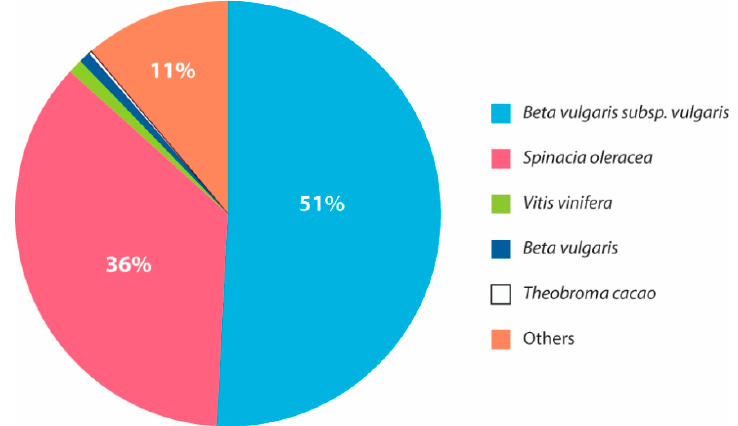
Figure 4. The percentage of similarity between the annotated H. persicum transcripts with other plant species.